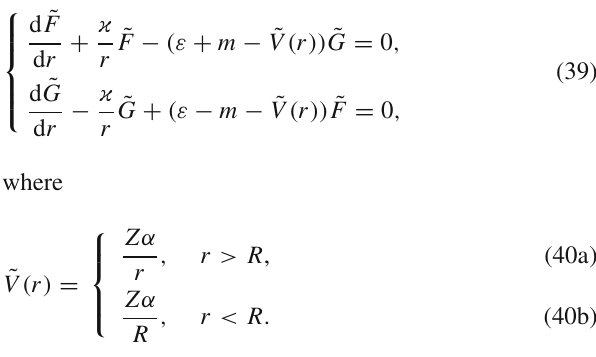
Table 1 The dependence of the ground state energy on Z for m · R = 0 . 031. The ground energy level enters the lower continuum at Z = 178 (though the imaginary part of ε is much smaller than the accuracy of the calculation). We see that for Z = 232 the accuracy of the approximate formula is about 10% for the Im [ ε